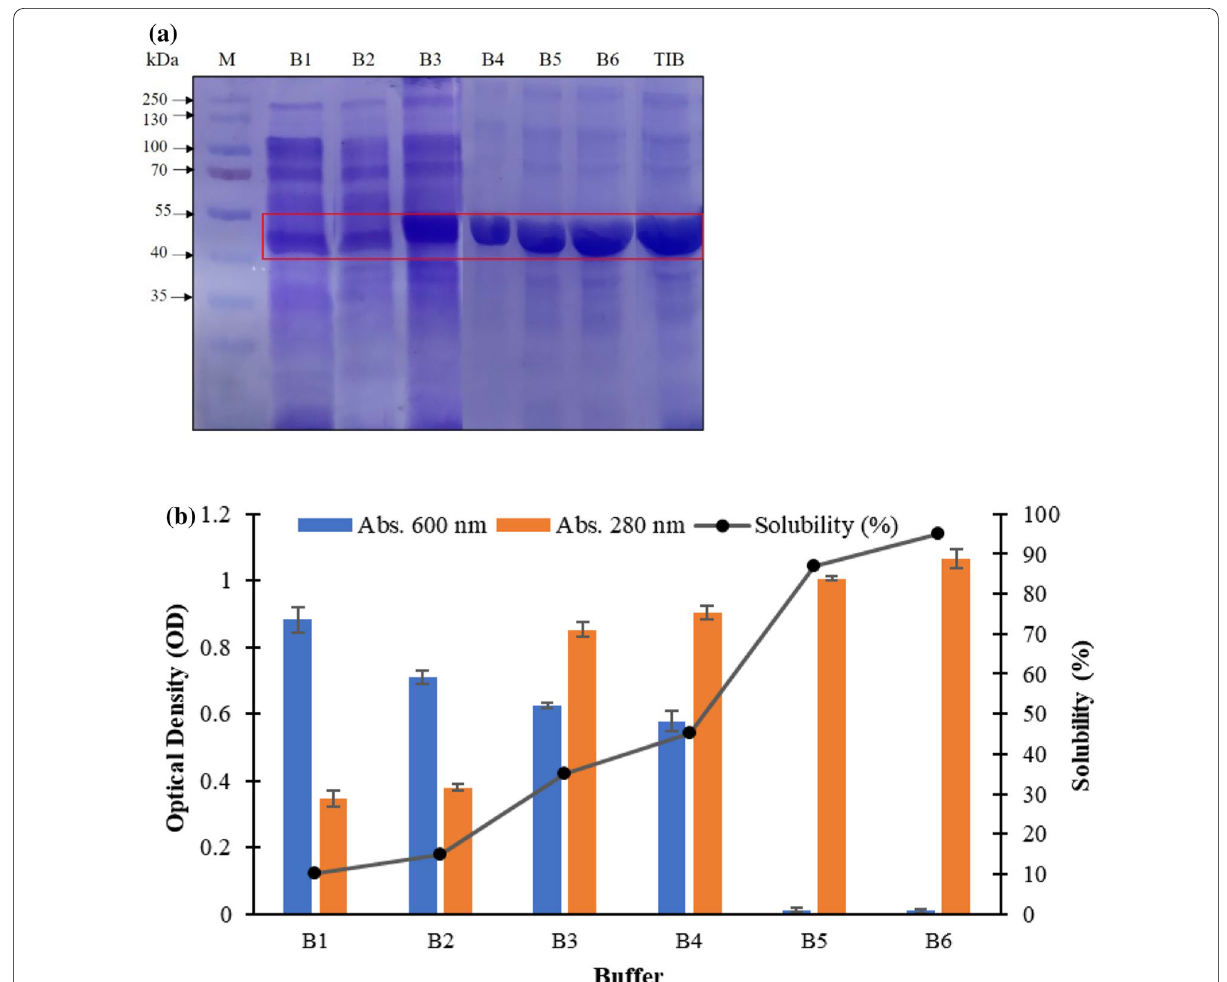
Fig. 3 Solubilization of rMtCel6A purified IBs using different solubilization buffers a SDS gel of solubilized IBs; M: protein marker; B1: Buffer 1, B2: Buffer 2, B3: Buffer 3, B4: Buffer 4, B5: Buffer 5, B6: Buffer 6 (composition as described in text), TIB: Total Inclusion Bodies [Protein ladder (PageRuler